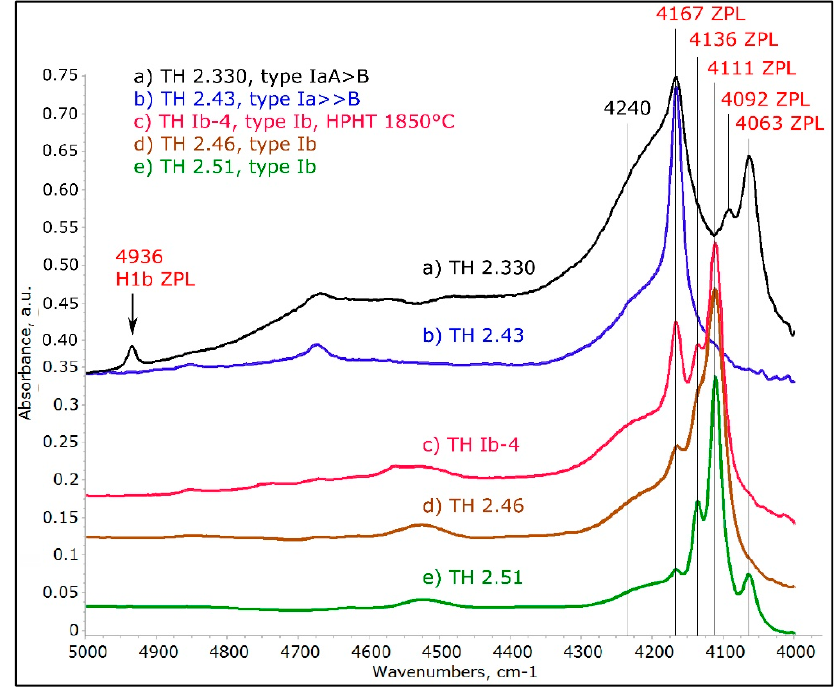
Figure 8. A detailed view of the AC ZPLs when recorded at 77 K. A total of 5 ZPLs can be seen and the band at 4240 cm − 1 is very likely identified as a vibronic component, since it does not sharpen significantly. A distinct H1b center can be seen in spectrum (a); when present in diamonds not associated with any type of irradiation/annealing, this peak is always associated with the AC at 4063 cm − 1 . The spectra were shifted vertically for clarity.